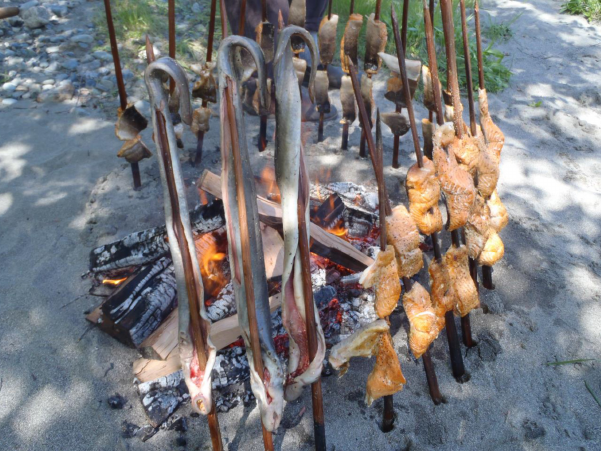
Fig. 3. A traditional tribal meal demonstrates an array of ecocultural resources, including lamprey and salmon prepared on coast redwood and western redcedar sticks over a madrone wood fire along the Salmon River, California, USA. April